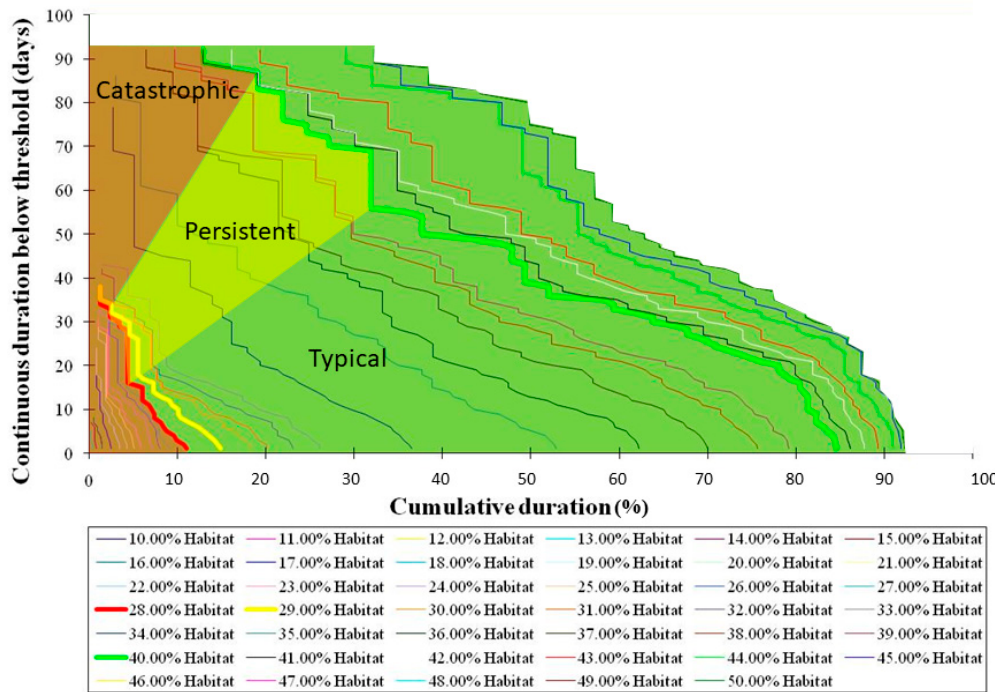
Figure 3. Example of uniform continuous under-threshold curves for determination of HST. Each curve on the diagram represents the cumulative duration of events when habitat is lower than a threshold (X-axis) for a continuous duration of days depicted on the Y-axis.